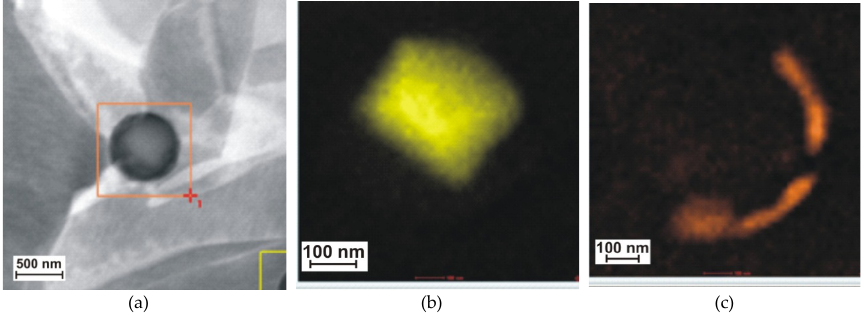
Figure 13. Titanium-niobium precipitates in the hybrid welded joint made of steel S700MC. ( a ) precipitate, ( b ) surface distribution of titanium, ( c ) surface distribution of niobium).